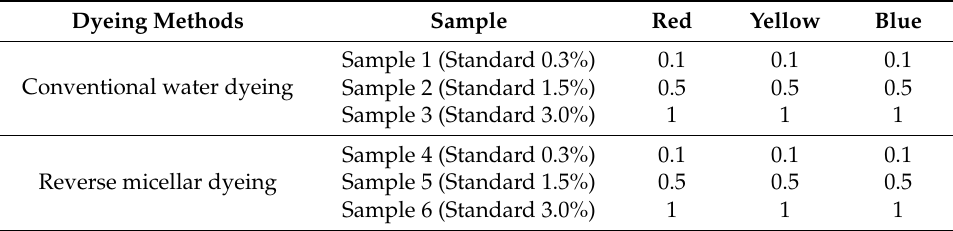
Table 4. Concentration of dye (% owf) for preparing colour